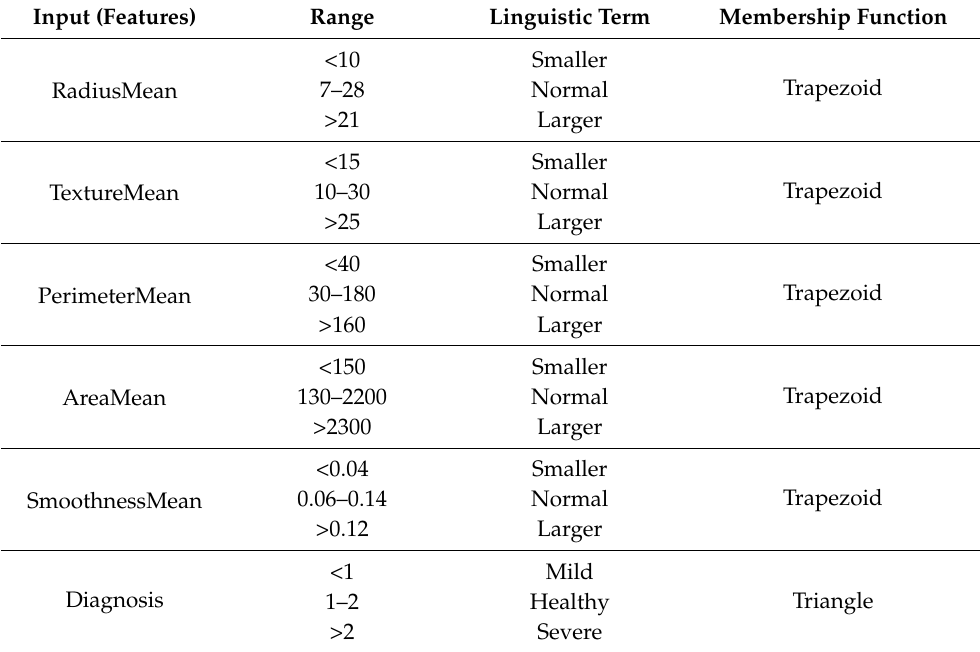
Table 5. Input and output features, ranges on linguistic terms, and membership